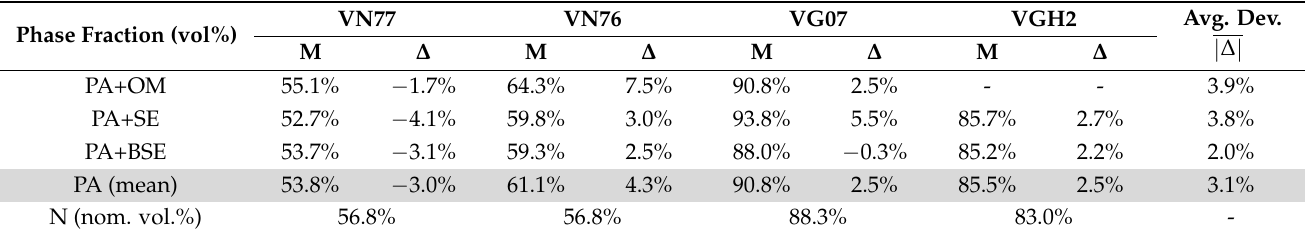
Table 7. Phase fractions (vol%) of the WC grains obtained by the PA.